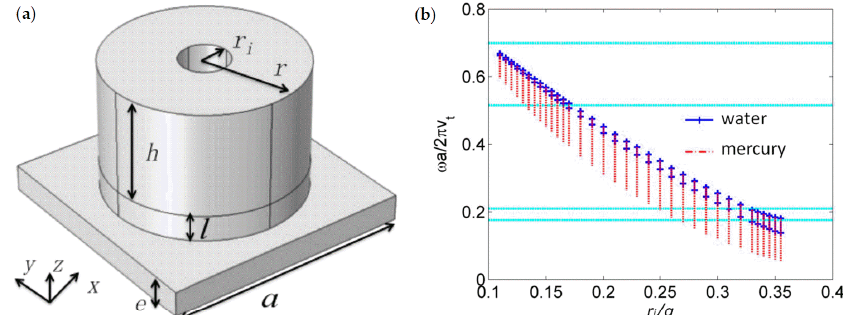
Figure 11. ( a ) Schematic view of a unit cell; ( b ) Varied range of whispering-gallery modes’ (WGMs) frequency crossing from Bragg band gap to low-frequency band gap when the holes are respectively empty or fully filled with the liquid: water (blue dotted lines) and mercury (red dotted lines), corresponding to increasing inner radius. Reproduced under a Creative Commons Attribution 4.0